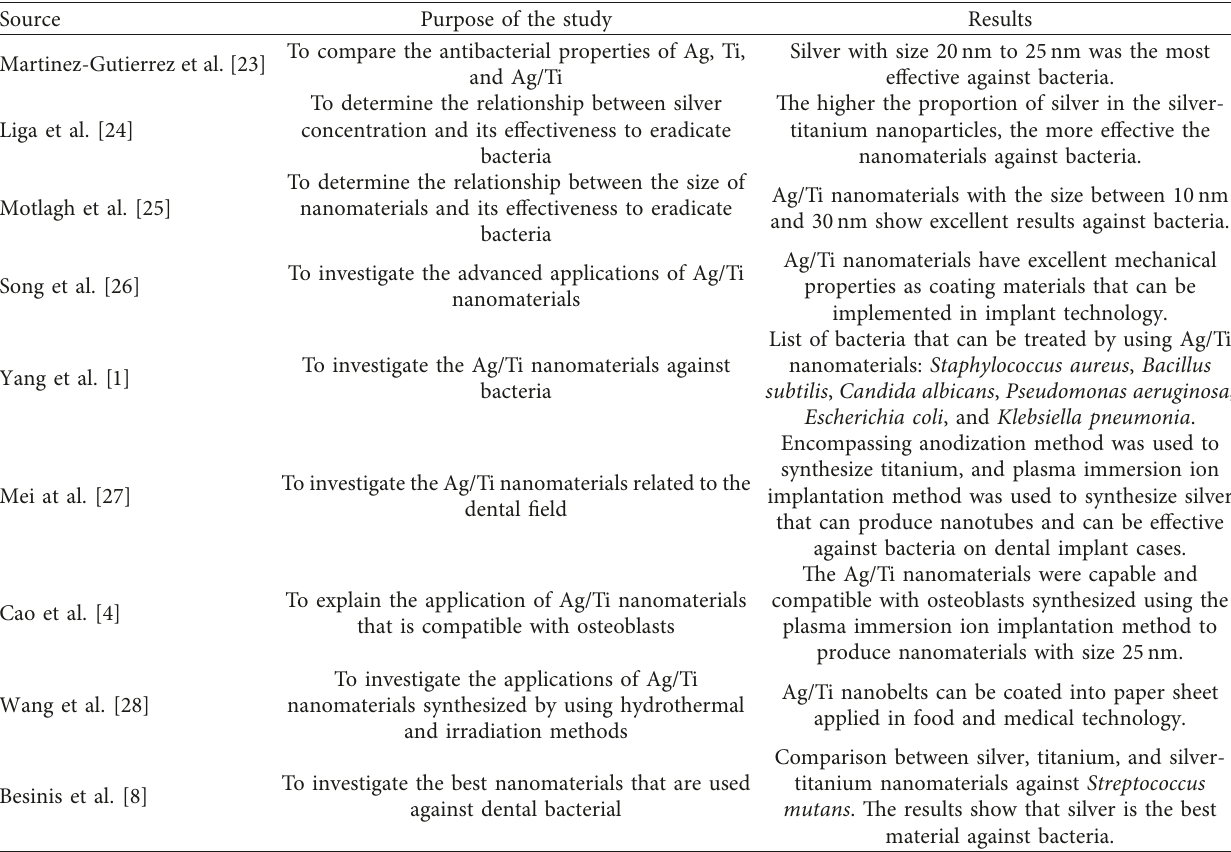
Table 1: Previous study of Ag/Ti